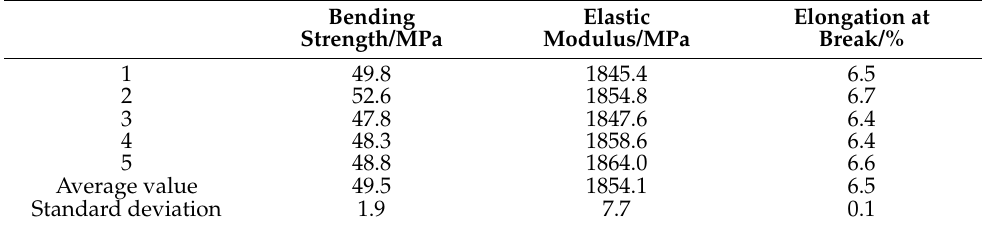
Table 6. Data of bending mechanical property for the cured